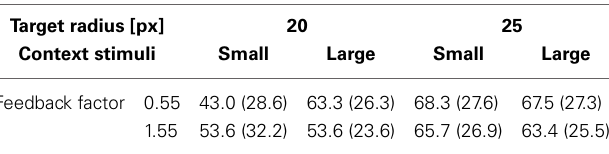
Table 5 | Mean hit rates [%] relating to the visible target surface in Experiment